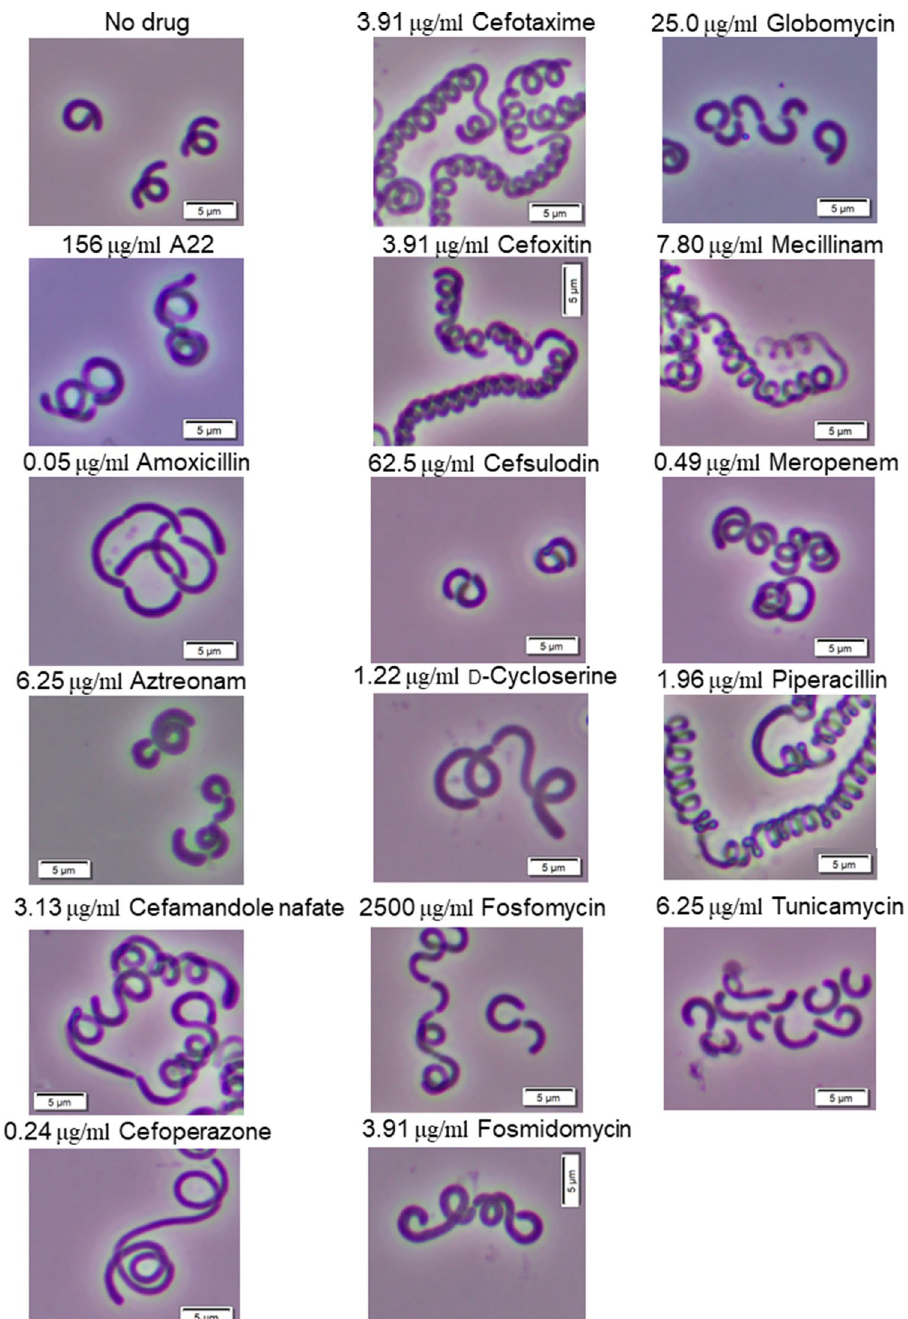
Figure 1. Cell shape of S. linguale ATCC33905 strain cells treated with various antibiotics. Microscopy of the ATCC33905 strain when cells were treated with the subinhibitory concentration of each antibiotic indicated above the image. Bar, 5 μm. Cells were cultivated in the stationary phase in Spirosoma medium containing the subinhibitory concentration of each antibiotic at 26 °C with shaking. The subinhibitory concentration of each antibiotic is shown alongside the name of